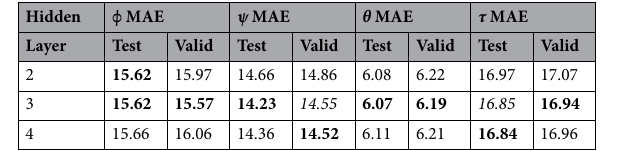
Table 3. Performance of the best angle specific SAP settings when the numbers of hidden layers in the DNNs are varied.